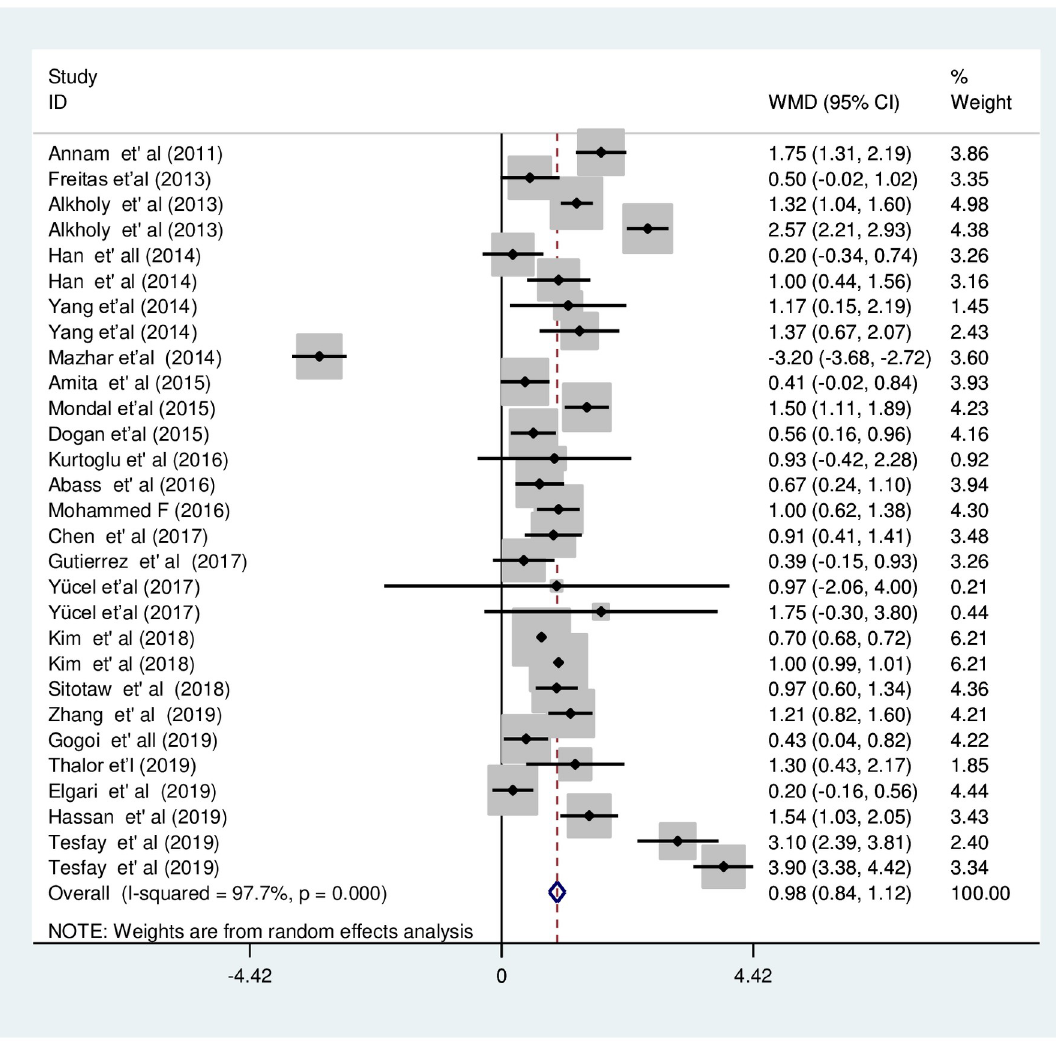
Fig 3. Forest plot of included studies for the pooled WMD estimate of MPV between PE and NT groups using a random effect model.